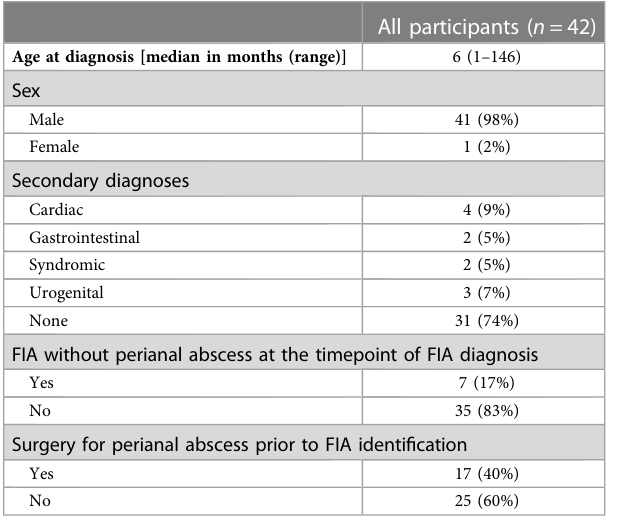
TABLE 1 Patients ’ demographical characteristics.